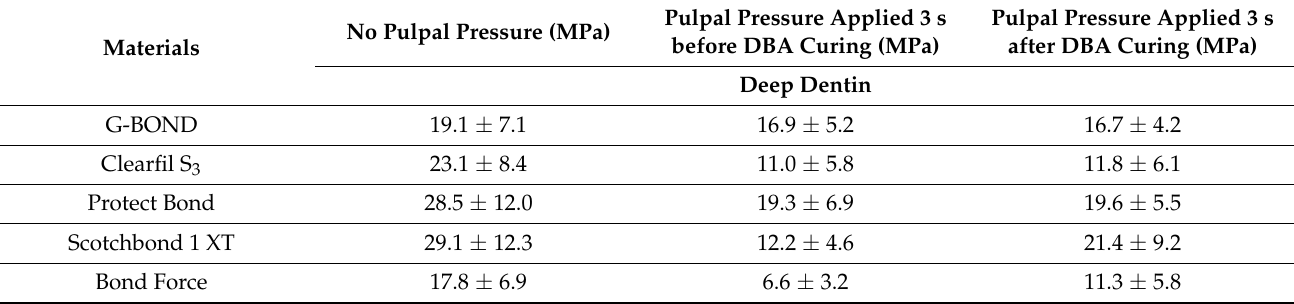
Table 1. Microtensile bond strengths (means ± standard deviations) of the DBAs bonded to deep dentin.